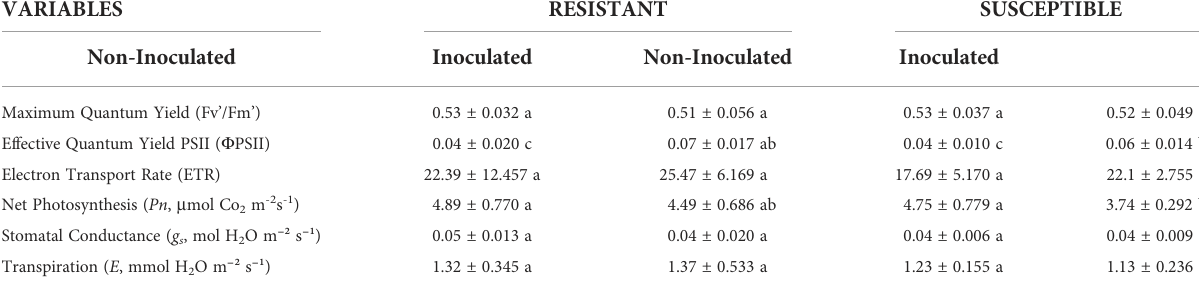
TABLE 1 Summary of the parameters associated with chlorophyll fl uorescence and gas exchange. In the case of chlorophyll fl uorescence, maximum quantum yield (Fv ’ /Fm ’ ), the effective quantum yield PSII ( F PSII), and electron transport rate (ETR) were evaluated.